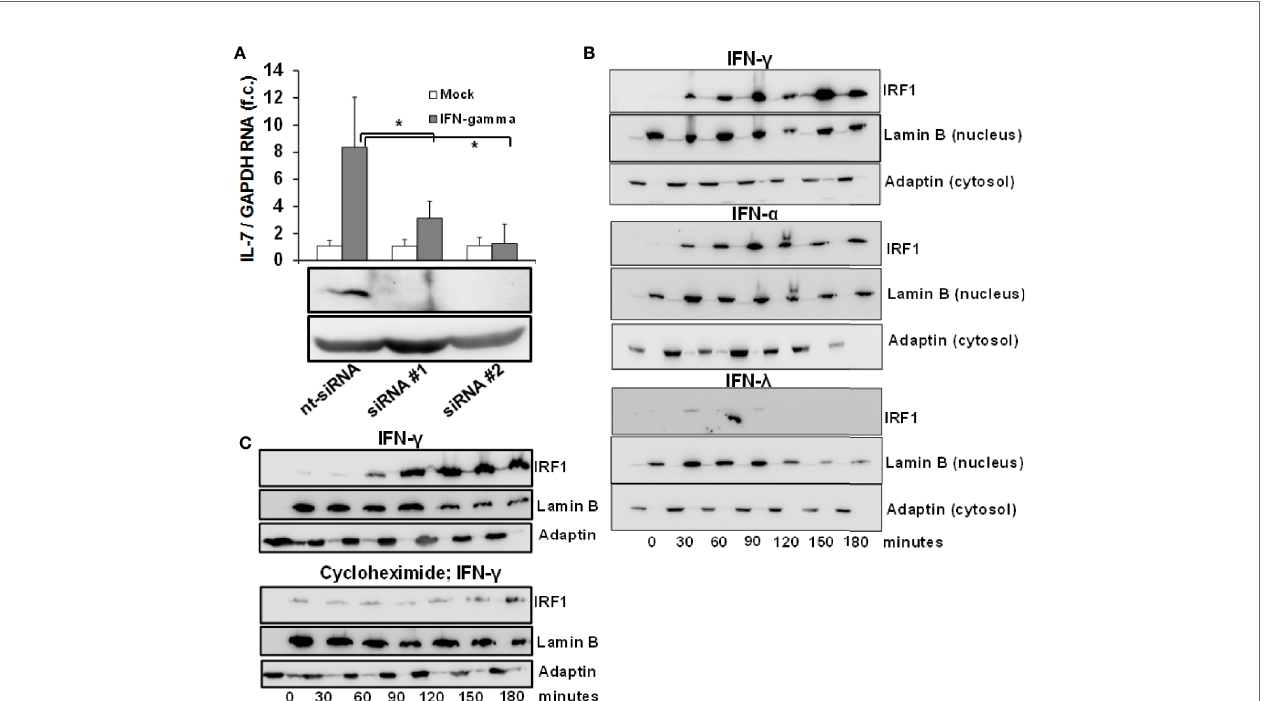
FIGURE 2 | Inducible interleukin-7 (IL-7)-expression in the hepatic system relies on interferon-response factor-1 (IRF1) protein translation. (A) Huh7.5 cells underwent gene silencing by treatment with IRF-1 siRNA or unspeci fi c control small interfering RNA (siRNA) for 24 h. After removing the siRNA, cells recovered for 24 h before being treated with 5 ng/ml interferon- (IFN)- g for 6 h. Levels of IL-7 mRNA relative to housekeeping GAPDH mRNA are expressed relative to untreated cells. Standard deviations of two independent experiments (n=2) performed with three replicates each are shown. * P < 0.05 for comparison of IFN-gamma treatment in nt-siRNA vs. siRNA#1 or siRNA#2 (gray bars). f.c., fold change. (B) IFN- a and IFN- g , but not IFN- l result in quickly ascending levels of nuclear IRF1 protein. Huh7.5 cells were treated with 5 ng/ml IFN- g (top), 500 i.E./ml IFN- a (middle), or 50 ng/ml IFN- l 2 (bottom) for the displayed time points. Cells were lysed and cytoplasmatic and nuclear proteins were collected in separate fractions as described. The levels of IRF-1 were assessed via Western Blot, where Lamin B and g - Adaptin are used as housekeeping proteins for the nuclear and cytosolic fractions, respectively. (C) De novo translation of IRF1 in response to type I IFN. Huh7.5 cells underwent pre-treatment with DMSO (top) or 50 µg/ml cycloheximide (bottom) for 6 h. After that, the cells were treated with 5 ng/ml IFN g for the indicated time points. The amount of IRF-1 was analyzed via Immunoblot, where Lamin B and g -Adaptin are used as housekeeping proteins for the nuclear and cytosolic fractions, respectively. In (B, C) , one out of three experiments (n=3) is shown as